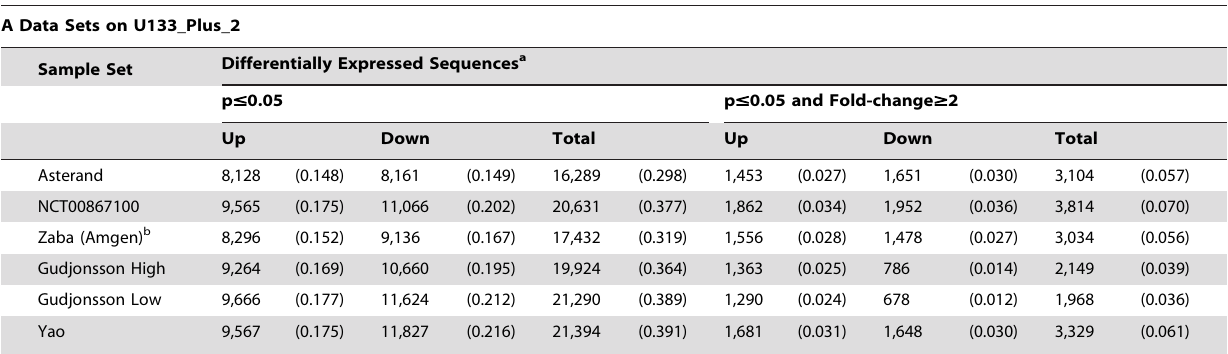
Table 3. Probe Sets Differentially Expressed at p-value Cut-offs or p-value and Fold-Change Cut-offs.